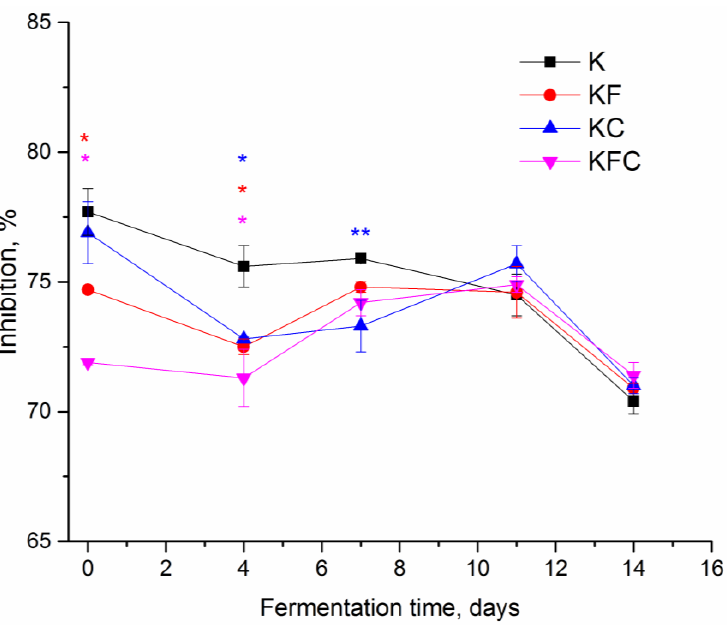
Figure 3. DPPH radical scavenging activity of kombucha during fermentation (K — control, KF — kombucha with algae extract, KC — kombucha with lichen extract, KFC — kombucha with a mixture of algae and lichen extracts). * Significantly different from K, * p < 0.01 (** p <